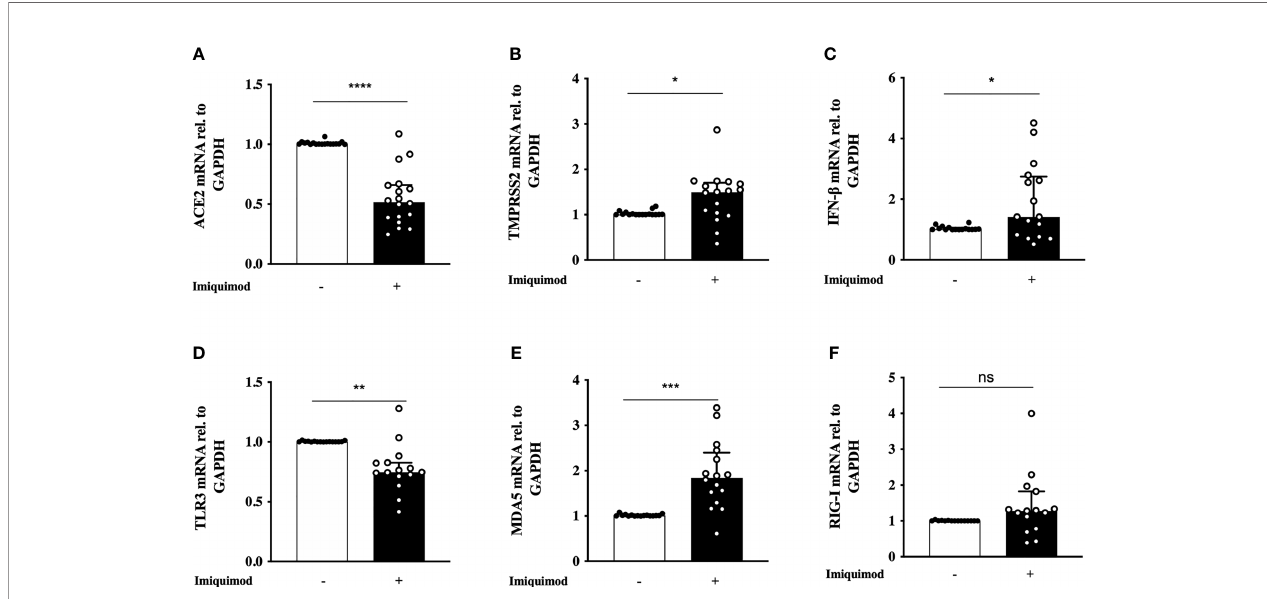
FIGURE 1 | Effect of imiquimod treatment on SARS-CoV-2 receptor expression and IFN response in human bronchial epithelial cells (HBECs) from asthmatics. Imiquimod effect on the mRNA expression of ACE2 (A) and TMPRSS2 (B) in HBECs from asthmatic patients. (C – F) Imiquimod effect on the anti-viral response of bronchial epithelium. IFN- b mRNA expression (C) , as well as the pattern recognition receptors TLR3 (D) , MDA5 (E) , and RIG-I (F) are shown. HBECs from study population 1 and 2 were used, N = 16-18. Wilcoxon Signed Rank Test. ns, not signi fi cant; *p < 0.05; **p < 0.01; ***p < 0.001; ****p <